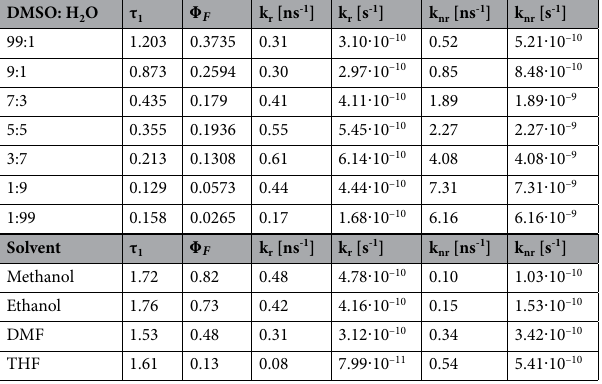
Table 3. Rate constants of radiative ( k r ) and non-radiative ( k nr ) intramolecular processes for NTBD in various solvents and mixed DMSO: H 2 O systems.